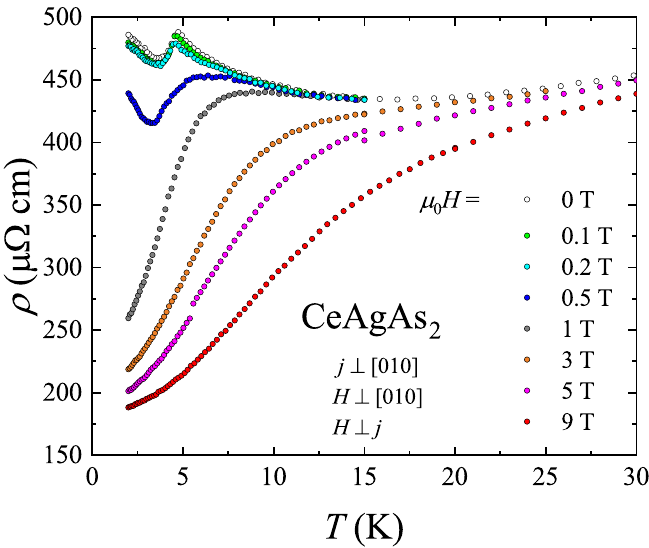
Figure 8. Low-temperature dependencies of the electrical resistivity of single-crystalline CeAgAs 2 measured with electric current flowing in the orthorhombic (010) plane and magnetic field of different strength applied perpendicular to it yet confined in the same